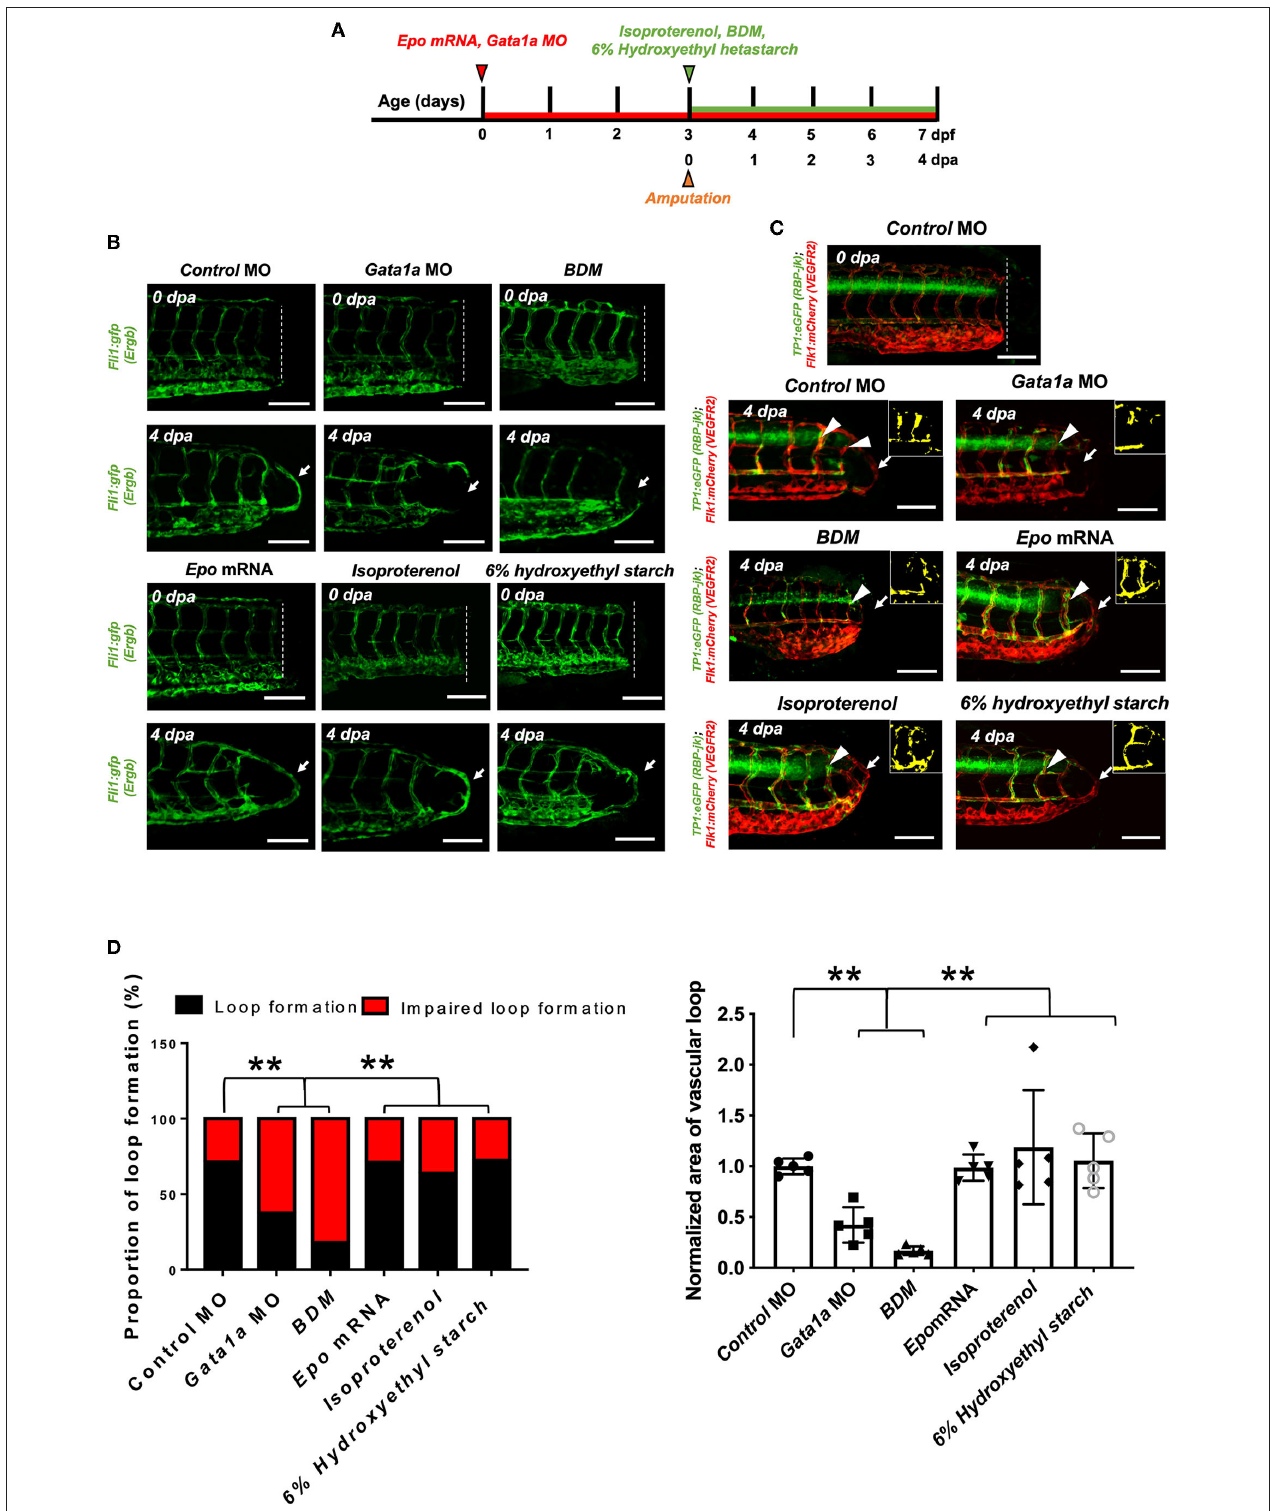
FIGURE 2 | Changes in WSS modulate DLAV-PCV loop formation in a Notch-dependent manner. (A) Experimental design to genetically and pharmacologically manipulate hemodynamic WSS in zebrafish embryos. (B) In response to tail amputation, Gata1a morpholino oligonucleotides (MO) injection (1mM) or 2,3-butanedione monoxime (BDM, 100 µ M) treatment impaired vascular loop formation at 4 dpa (white arrows). Erythropoietin ( epo ) mRNA injection (10–20 pg/nl),